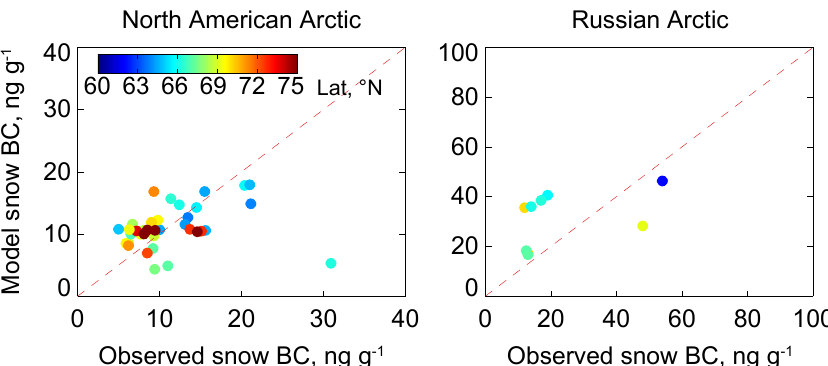
Fig. 13. Scatterplots of simulated vs. observed BC content in snow for North American and Russian Arctic sites in Mar–May 2007–2009 (Fig. 12). Observations from Doherty et al. (2010) are averaged over model grid squares, and model results are sampled for the month and year of observations. The data are colored by latitude. Also shown is the 1:1